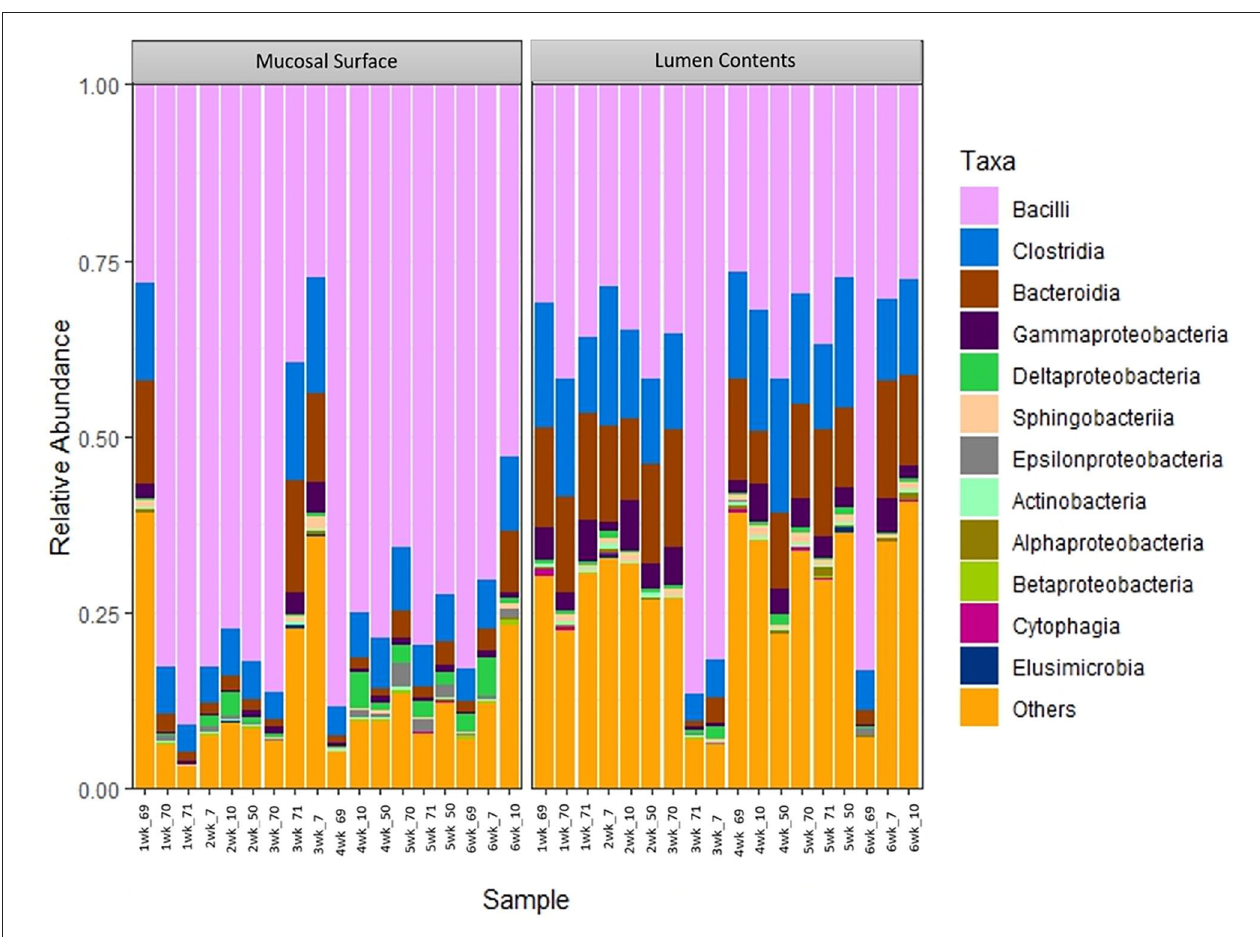
FIGURE 5 | Bacterial class. Stacked bar chart representing the abundance of the microbiota at the class taxonomic level in the mucosal biopsy surface and lumen contents across the sampled weeks for each animal.